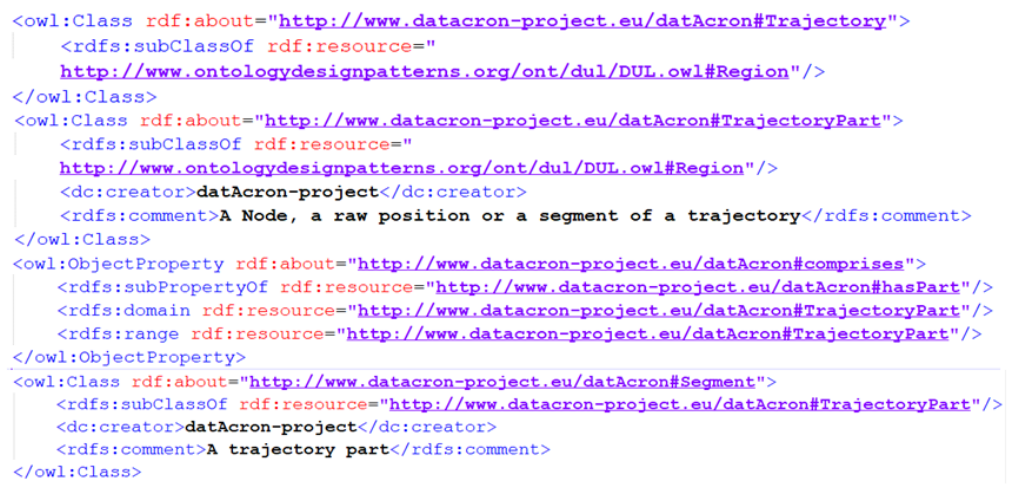
Figure 7. Semantic trajectory definition according to datAcron ontology.